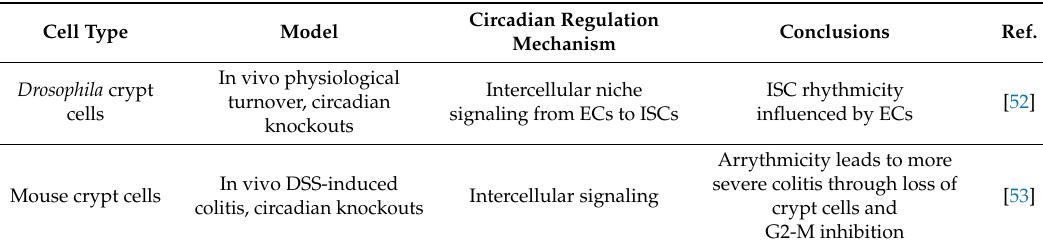
Table 2. Circadian intestinal stem cell niche interactions in